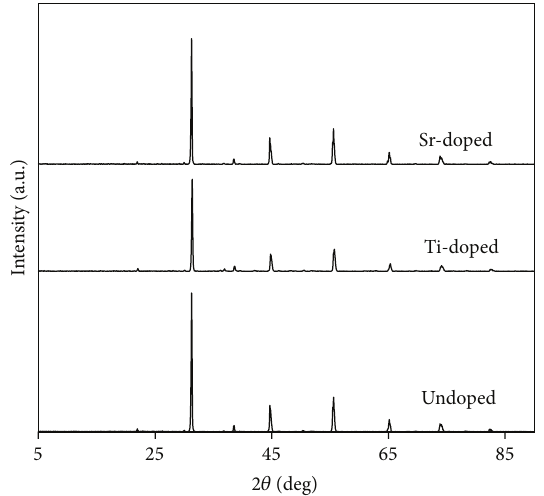
Figure2:XRDpatternsoflowervalencecation-dopedandundoped LaNbON 2 synthesized by the ammonothermal